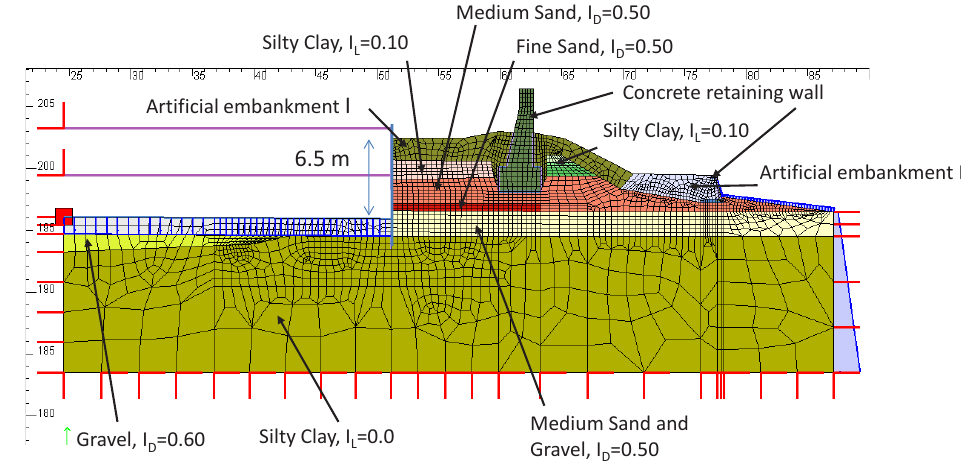
Figure 11: Numerical model of the deep excavation near the embankment – finished excavation.